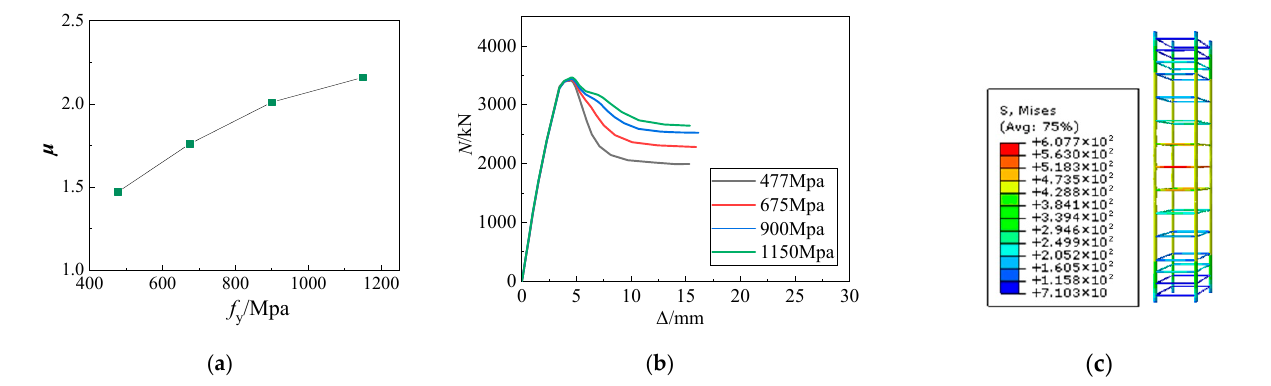
Figure 14. The simulation results at different stirrup strengths: ( a ) the ductility coefficient at different stirrup strengths; ( b ) the N – Δ curves at different stirrup strengths; ( c ) the rebar stress nephogram of specimen S7.